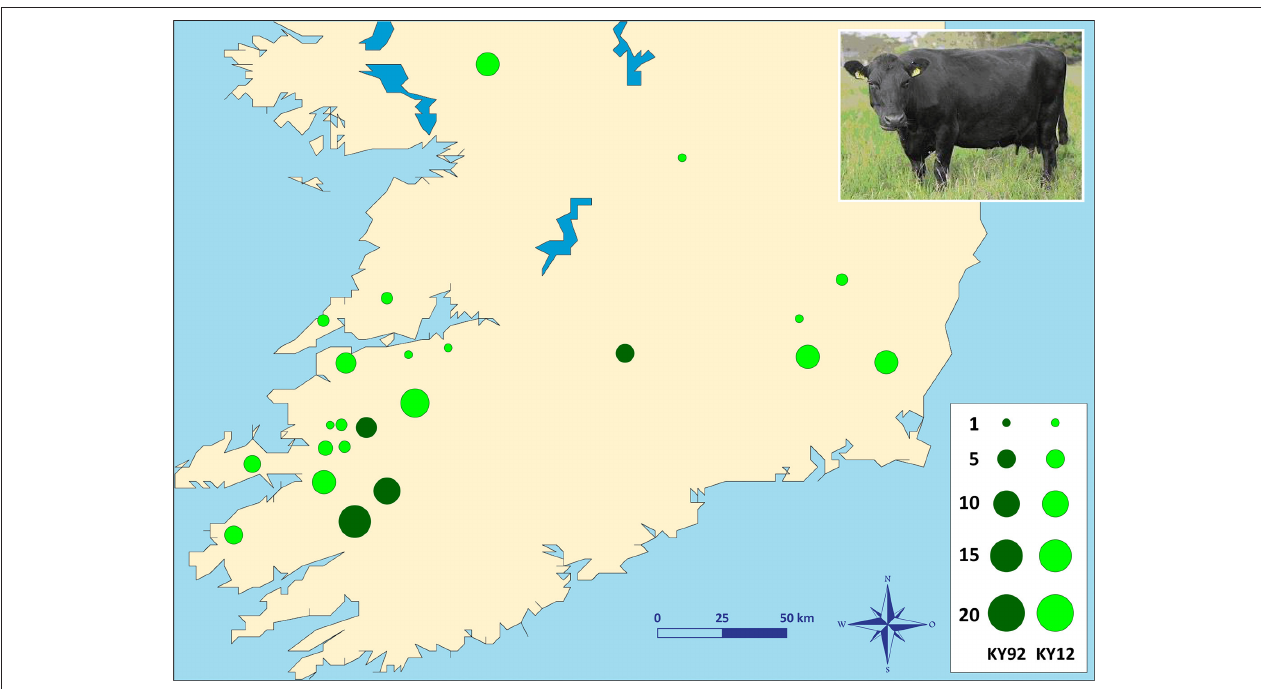
FIGURE 1 | Photograph of a Kerry cow and locations of Kerry cattle herd DNA sampling in southern Ireland. The area of each circle corresponds to the size of each population sample. Dark green = animals sampled during 1991/92 (KY92); light green = animals sampled during 2011/12 (KY12). Kerry cow image is copyright of the Kerry Cattle Society